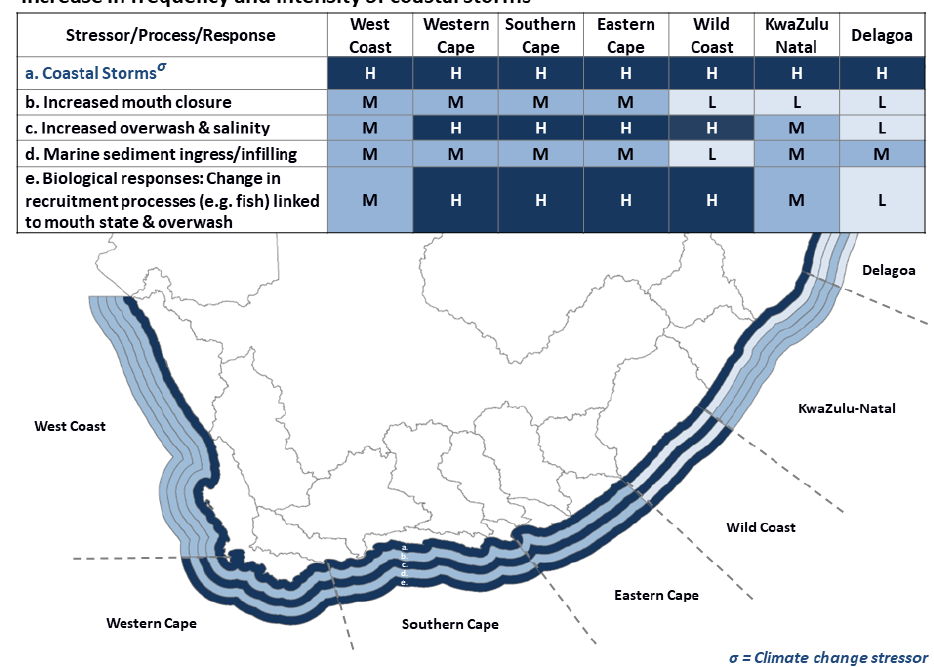
Figure 5. Summary of vulnerability ranking (high/medium/low) for estuaries in seven regions associated with increased sea storminess (colour zones on map depict ( a ) to ( e ) in the table moving outward from the coast with H = high, M = medium, L = low).